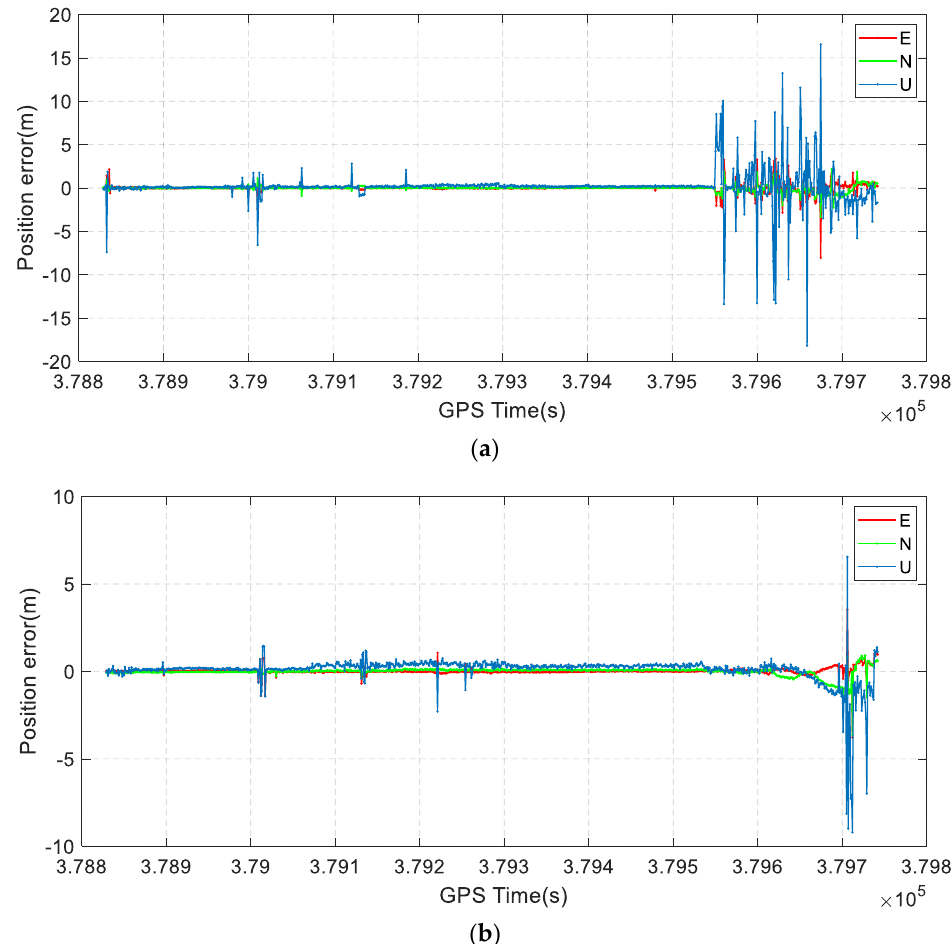
Figure 9. The tightly coupled positioning error of the BDS-2 triple-frequency and BDS-3 four-frequency with INS: ( a ) BDS-2/INS; ( b ) BDS-3/INS.